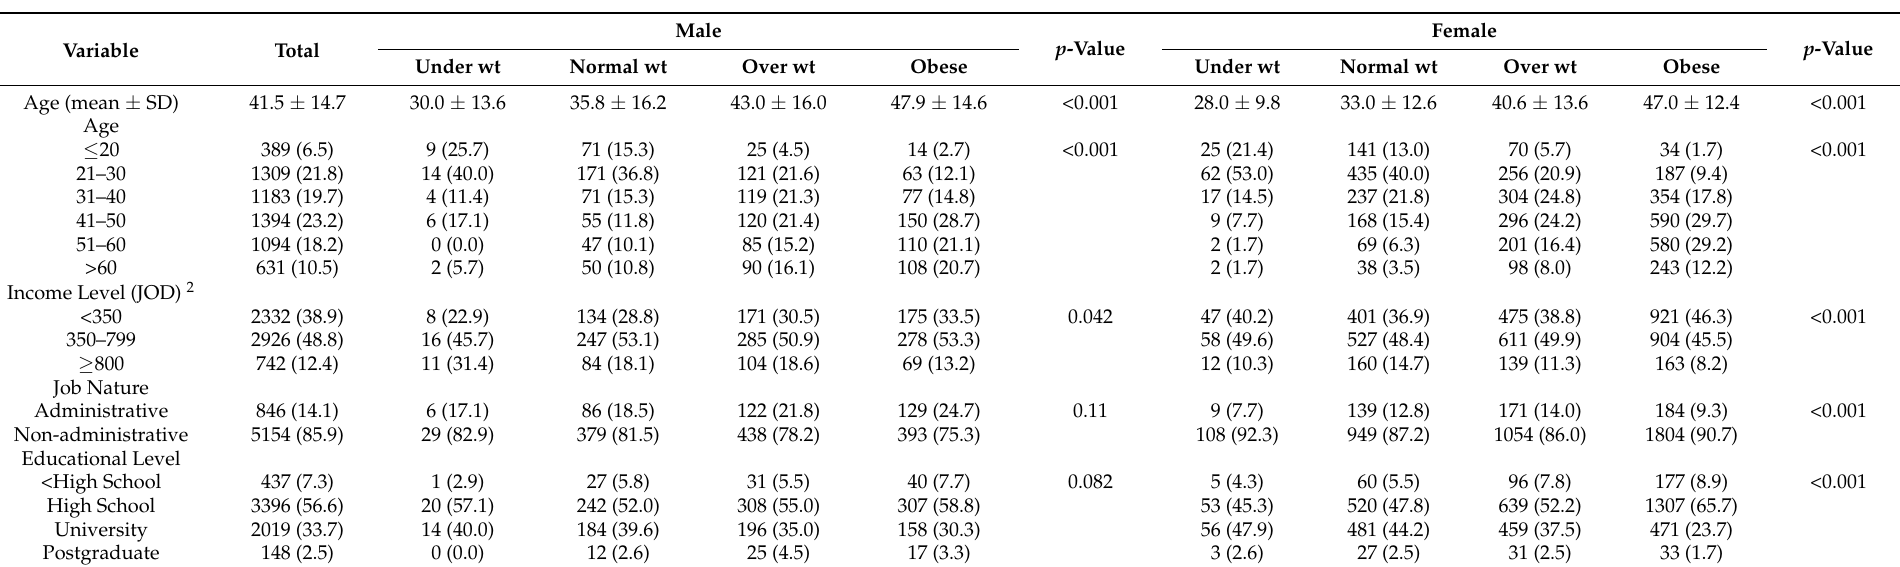
Table 1. BMI relation with population characteristics stratified by sex 1